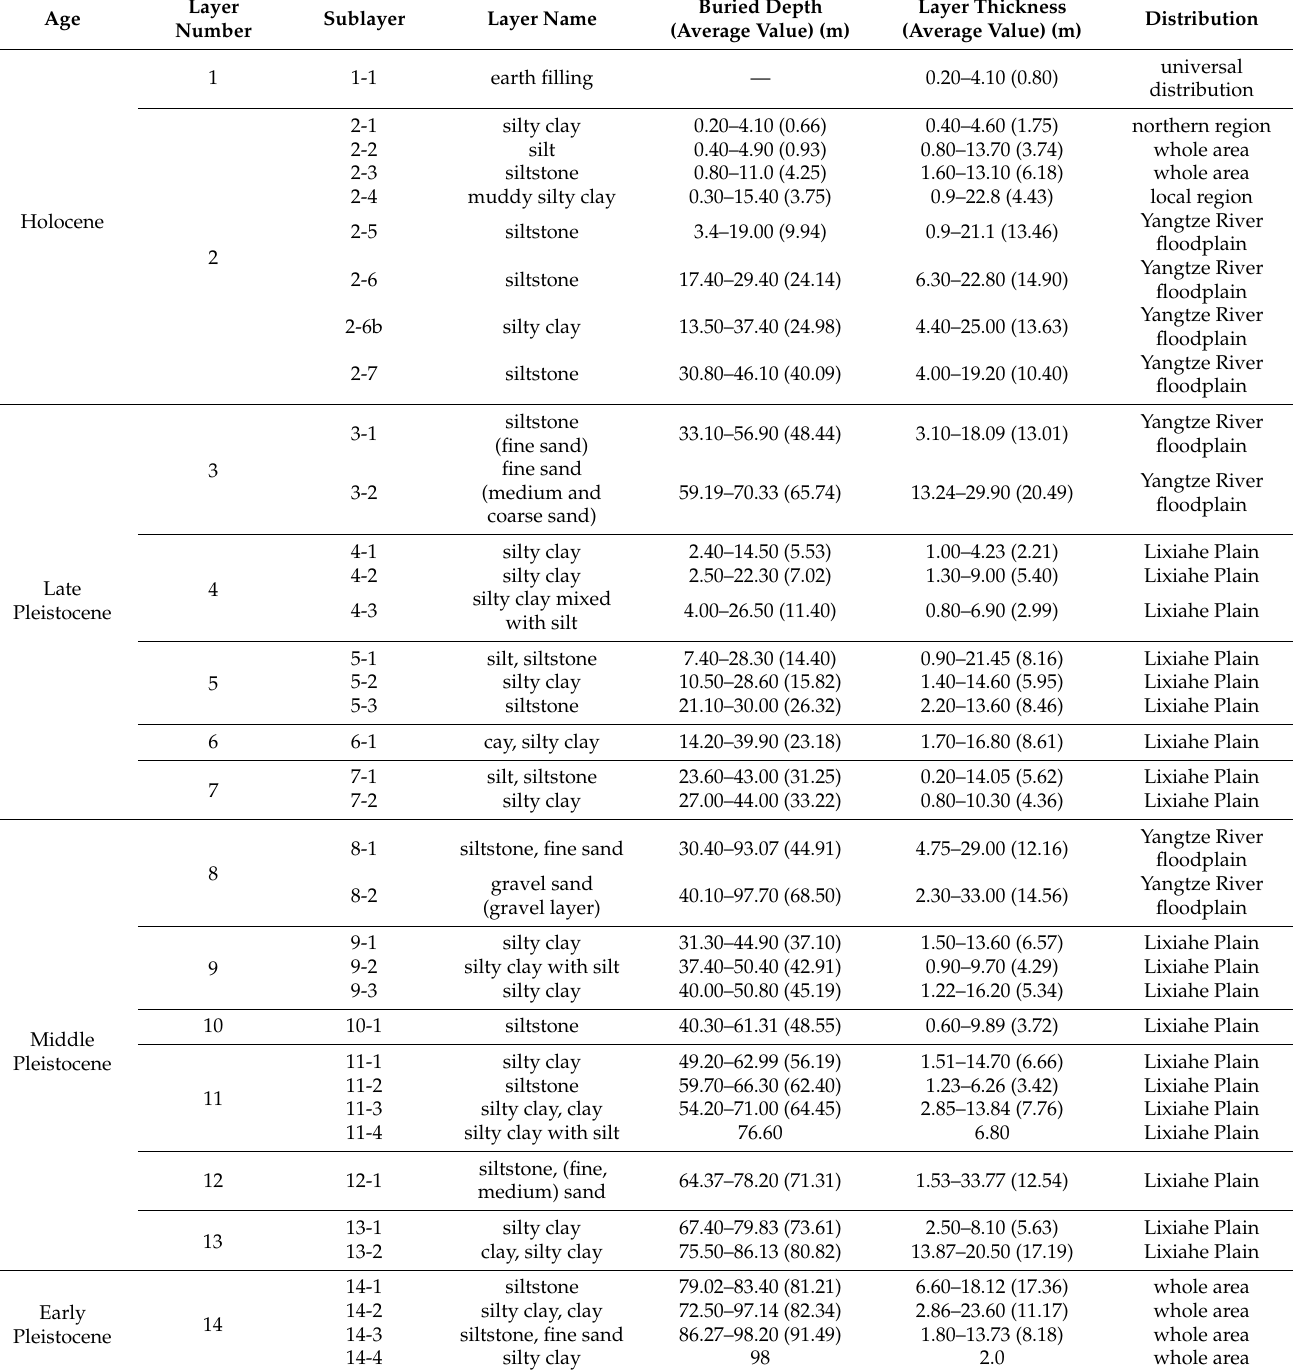
Table 2. Detailed stratigraphic information for the